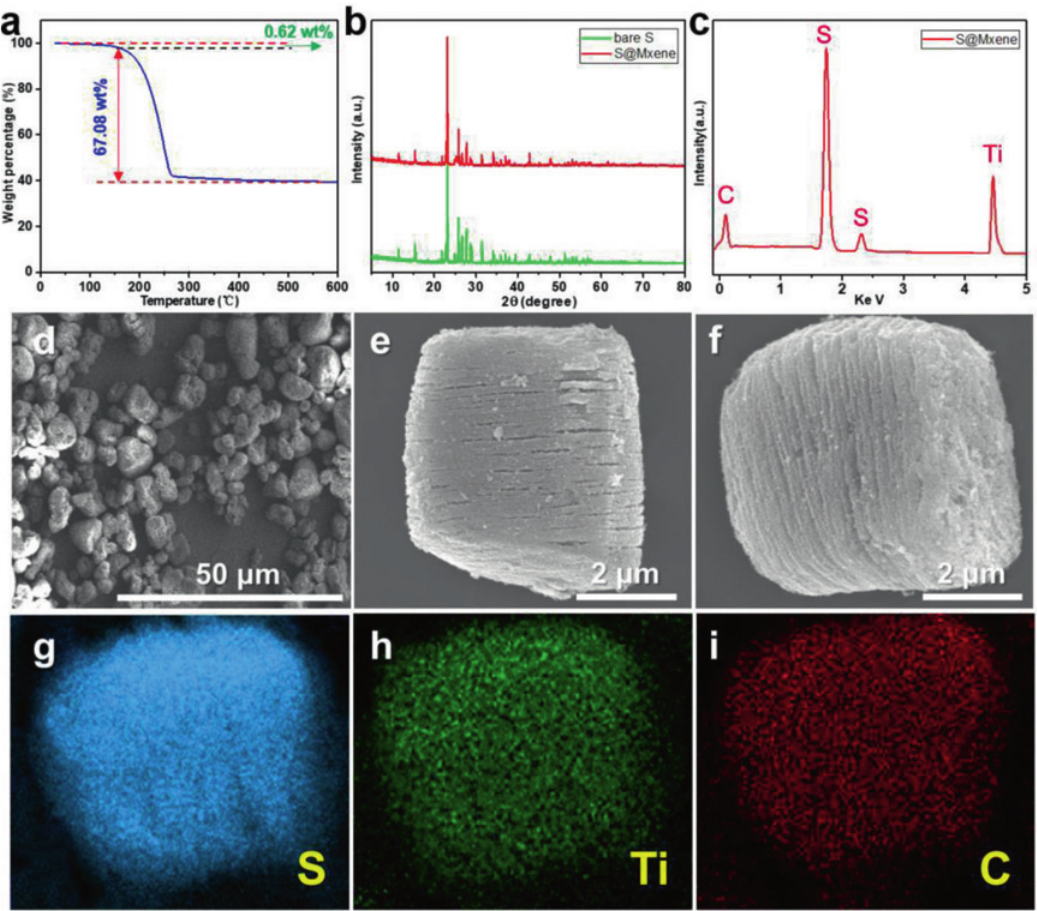
Figure 3: (a) TGA of S@Mxene. (b) XRD patterns of bare sulfur and S@Mxene. (c) EDX pattern of S@Mxene. (d – f) SEM images of S@Mxene. Element mappings of S@Mxene: S (g), Ti (h), C